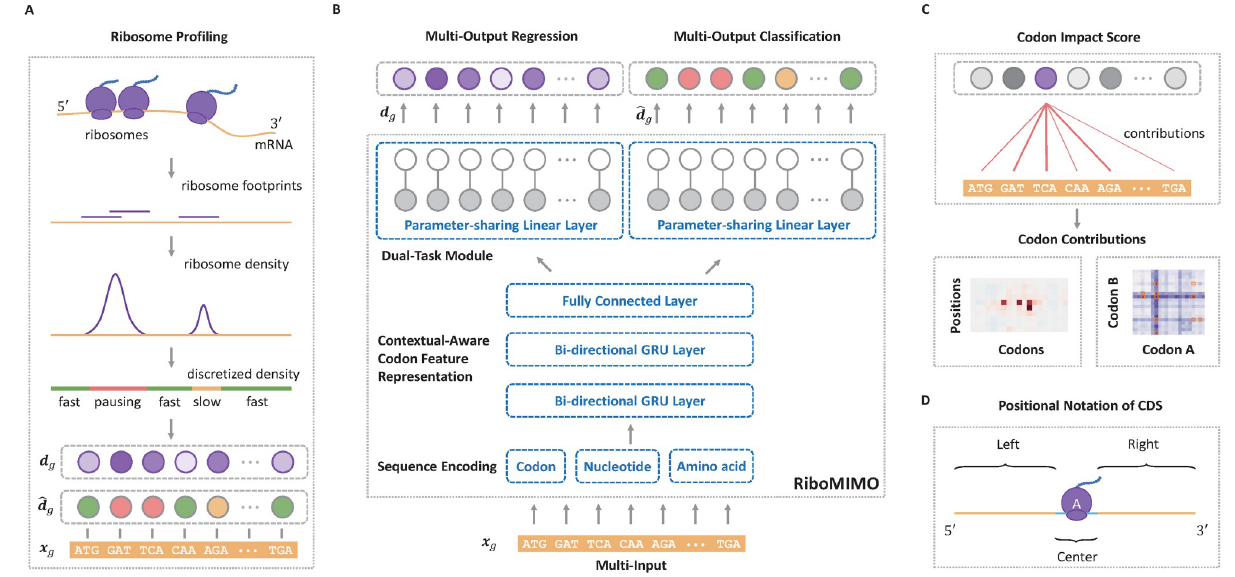
Fig 1. Overview of the RiboMIMO pipeline. (A). Schematic illustration of the input ribosome profiling data. The ribosome protected fragments were first sequenced and then aligned to the genome. Next, the ribosome densities are obtained after eliminating the bias of mRNA abundance levels. After that, the ribosome densities are categorized into three classes, including “fast”, “slow” and “pausing”. Both the ribosome densities d and the g corresponding discretized labels ^ d are used as the output targets of our model while the CDS sequence x g is used as the input. (B). The RiboMIMO g architecture, which includes encoding, feature embedding and dual-task modules. The feature embedding module employs a deep neural network to learn a context-aware feature representation for each codon based on a message propagation mechanism along the input full-length CDS sequence through a bi-directional gated recurrent unit (Bi-GRU) network, followed by a fully connected network. The dual-task module consists of two sub- modules, one is a basic regression task by a parameter-sharing single-layer neural network, while the other is a classification task by another parameter- sharing single-layer neural network. (C). The codon impact score (CIS) introduced by our RiboMIMO framework for measuring the contribution of a codon feature to the predicted ribosome density of the A site of another codon position within the CDS, or specific impact of any codon pair to the elongation rate of the transcript. (D). The positional notation for regions of a CDS sequence relative to the ribosomal A site. The region of ribosome footprints near the A site is denoted as “center”, with a length of 10 codons ranging from − 5 to + 4 positions, where the index of the A site is 0. The rest of the CDS sequence is separated into “left” and “right” regions, which range from the start codon to − 6 position at 5 0 end, and + 5 position to the stop codon at 3 0 end, respectively.